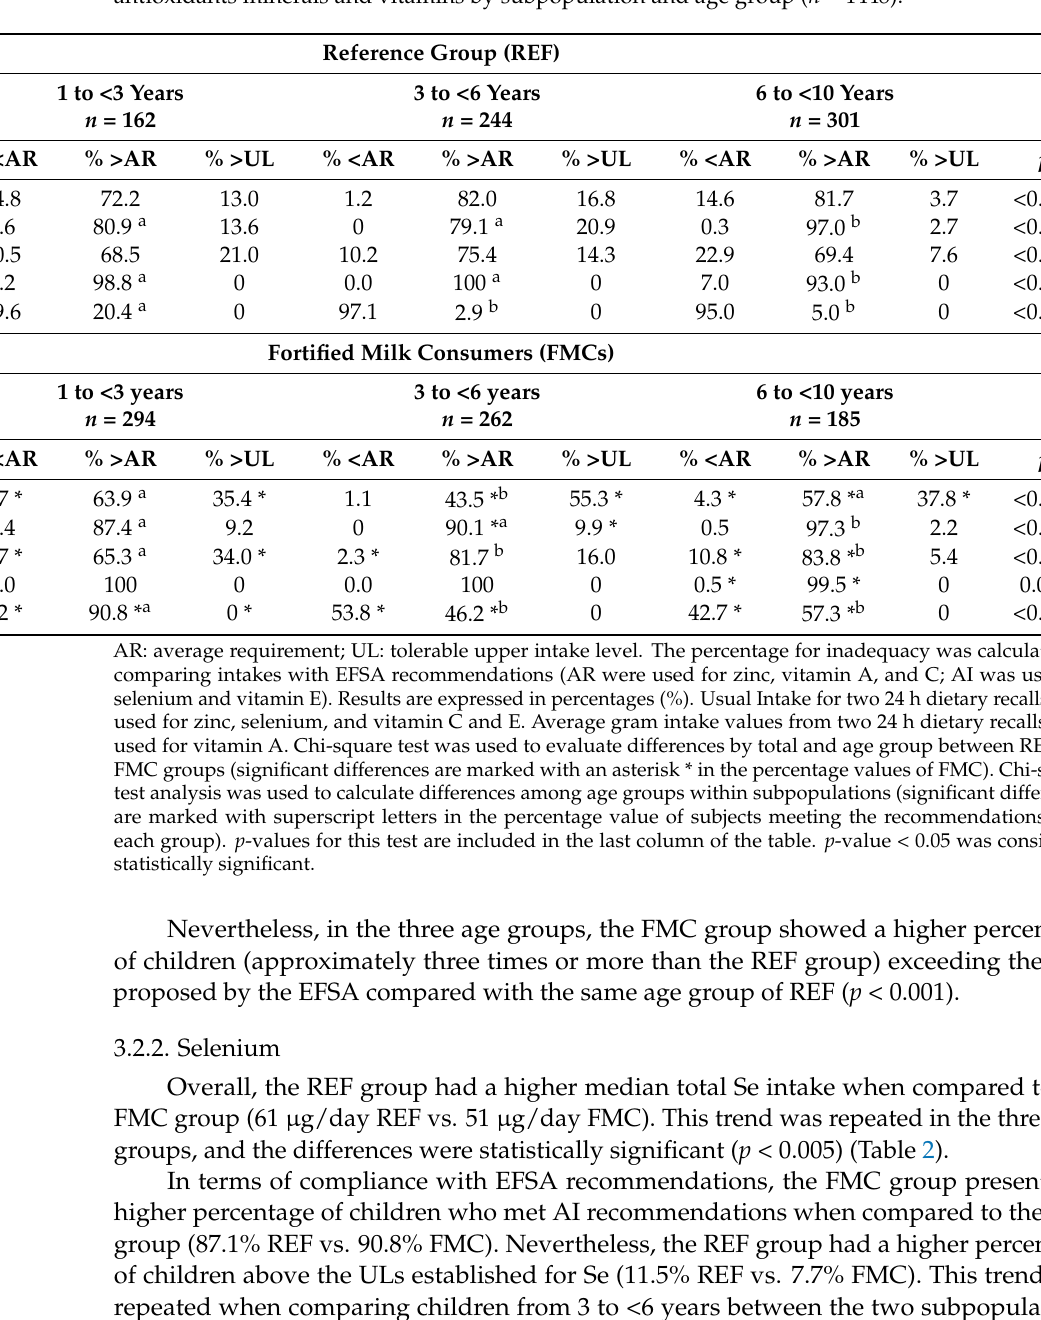
Table 3. Adequacies to the European Food Safe Authority (EFSA) recommendations (AR and AI) for antioxidants minerals and vitamins by subpopulation and age group ( n =